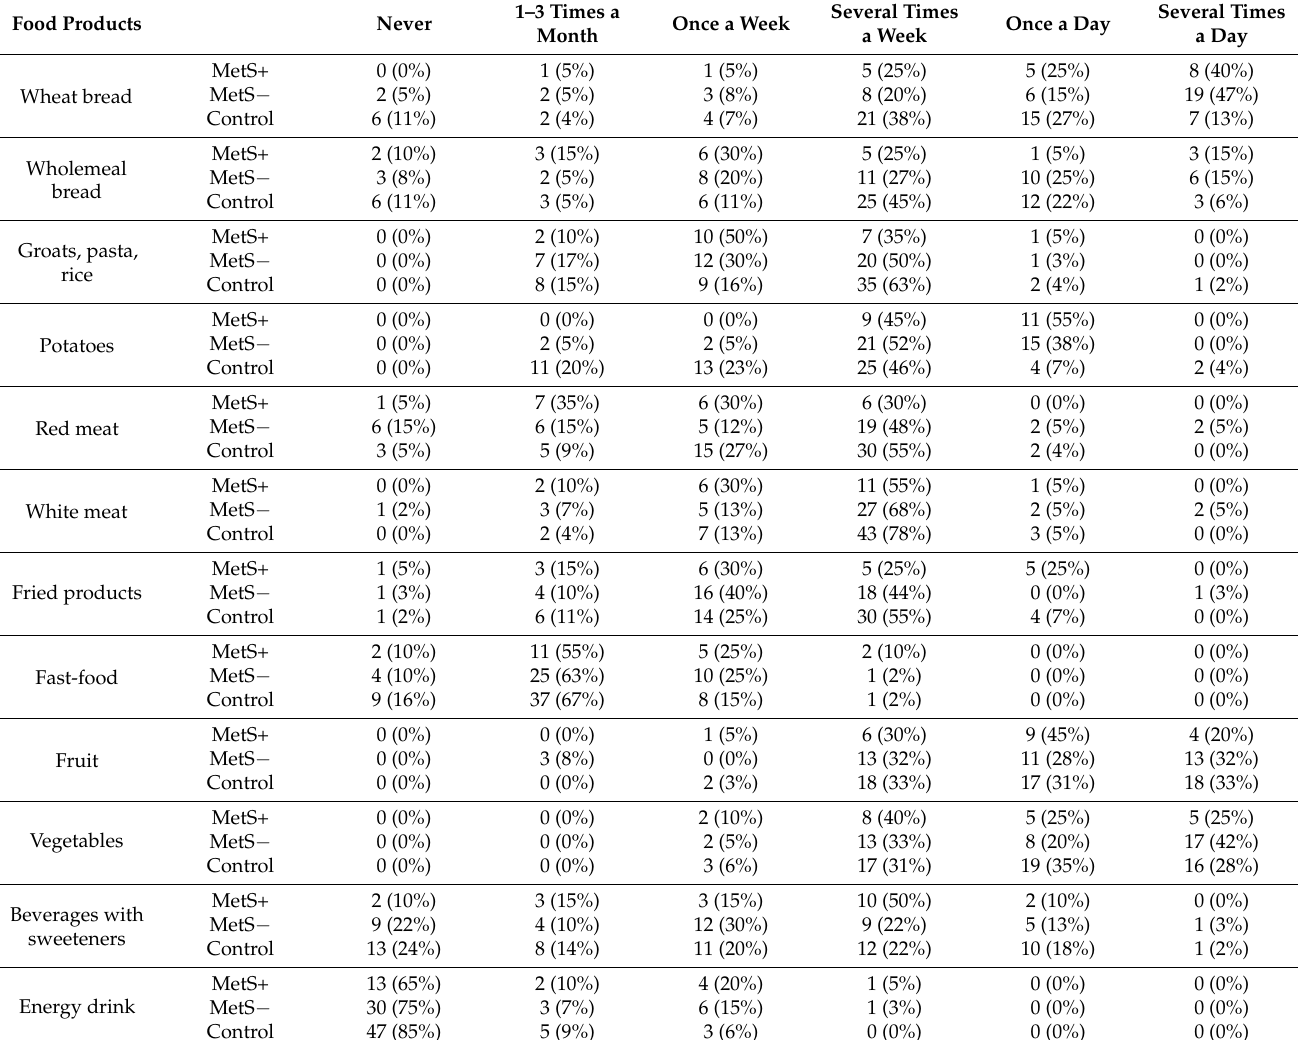
Table 9. Frequency of consumption of selected groups of food